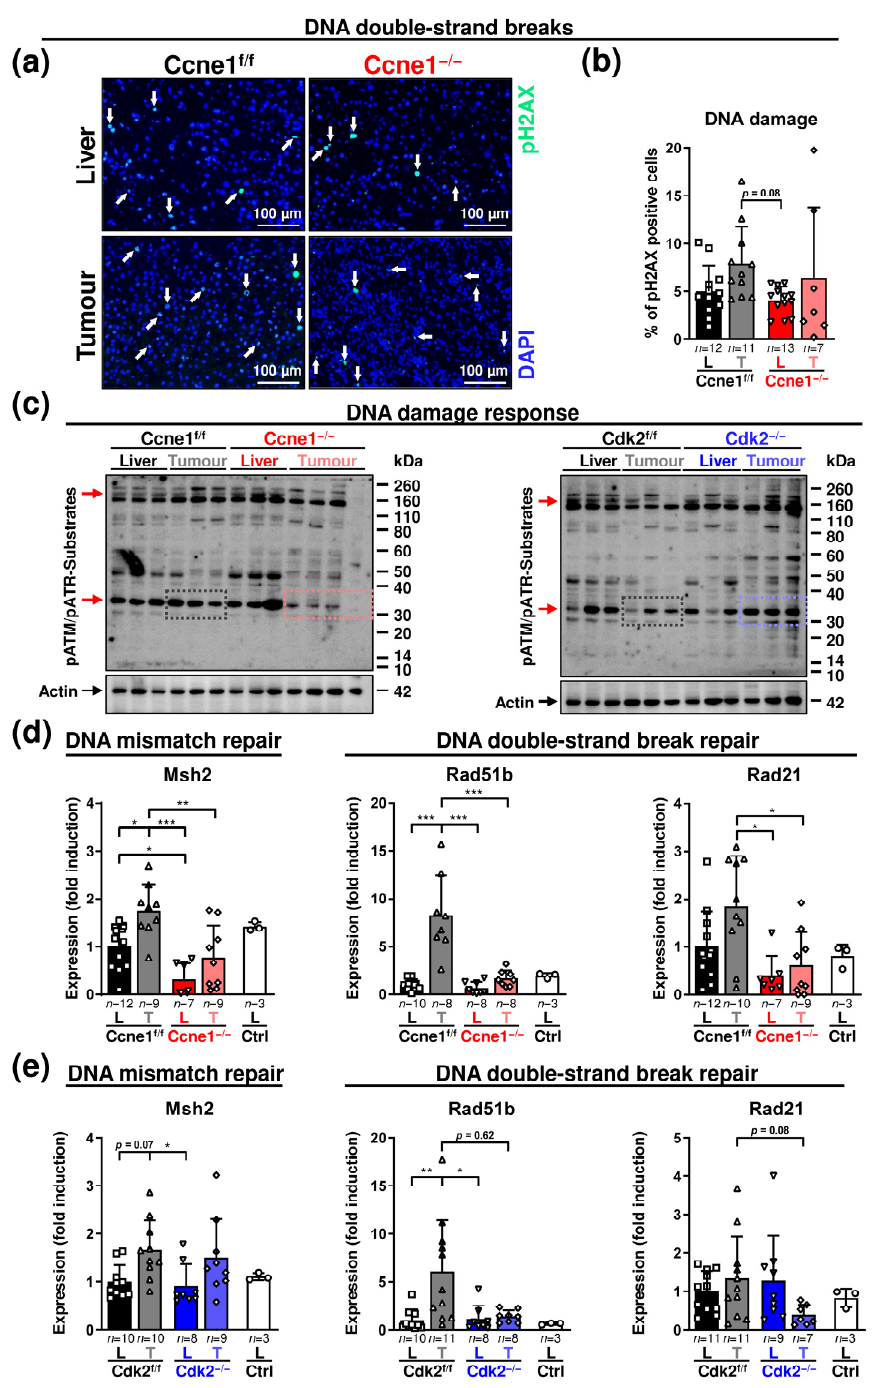
Figure 3. Absence of Ccne1 in advanced HCCs modifies the response to DNA damage. Two-week-old, Mx-Cre transgenic mice with floxed Ccne1 or Cdk2 alleles were treated with DEN. After tumour initiation, mice were repetitively injected with pIpC at week 22 to induce the deletion of Ccne1 or Cdk2 (Ccne1 − / − , Cdk2 − / − ). Mx-Cre -negative mice also received both DEN and pIpC and served as wildtype controls (Ccne1 f/f , Cdk2 f/f ). HCC progression was analysed after week 40. Details are given in Figure 1 and in the method section. L: liver; T: tumour tissue. ( a ) Immunofluorescence staining of phosphorylated Histone 2AX (pH2AX, green) in liver and tumour cryosections. Total nuclei were stained with 4 ′ ,6-diamidino-2-phenylindole (DAPI, blue). Arrows indicate pH2AX-positive cells. ( b ) Quantification of pH2AX-positive cells (%). ( c ) Immunoblot analysis detecting phosphorylated substrates of Ataxia telangiectasia mutated/Ataxia telangiectasia and Rad3-related (ATM/ATR) kinases. Beta actin served as loading control. Red arrows: reduced phosphorylation of unknown substrates specifically in tumorous tissues of Ccne1 − / − animals. ( d , e ) Gene expression analysis of Mut-S homologue 2 ( Msh2 ), Rad51b and Rad21 in ( d ) CcnE1 f/f and CcnE1 − / − or ( e ) Cdk2 f/f and Cdk2 − / − animals. Ctrl: livers of untreated wildtype mice.